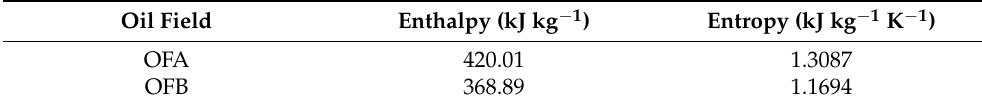
Table 2. Properties of the produced waters for the calculation of energy